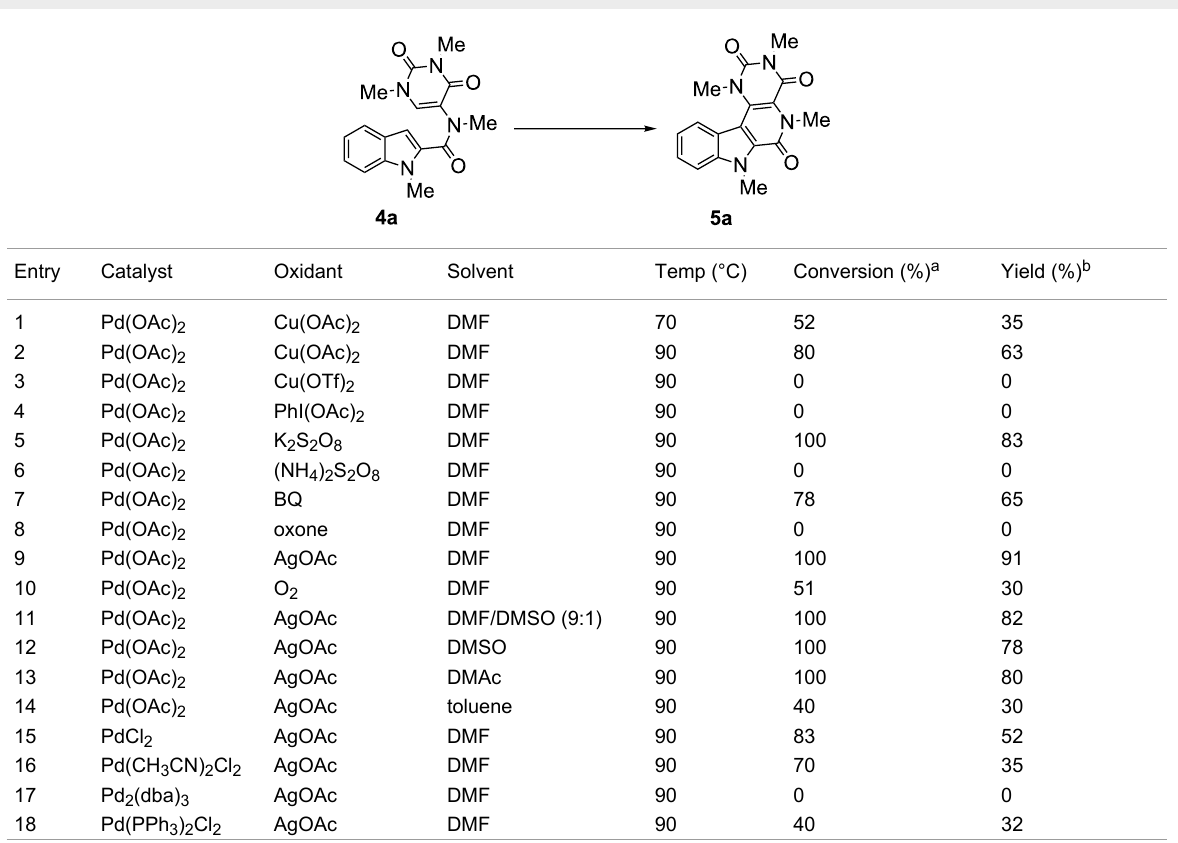
Table 1: Optimization of intramolecular dehydrogenative coupling.